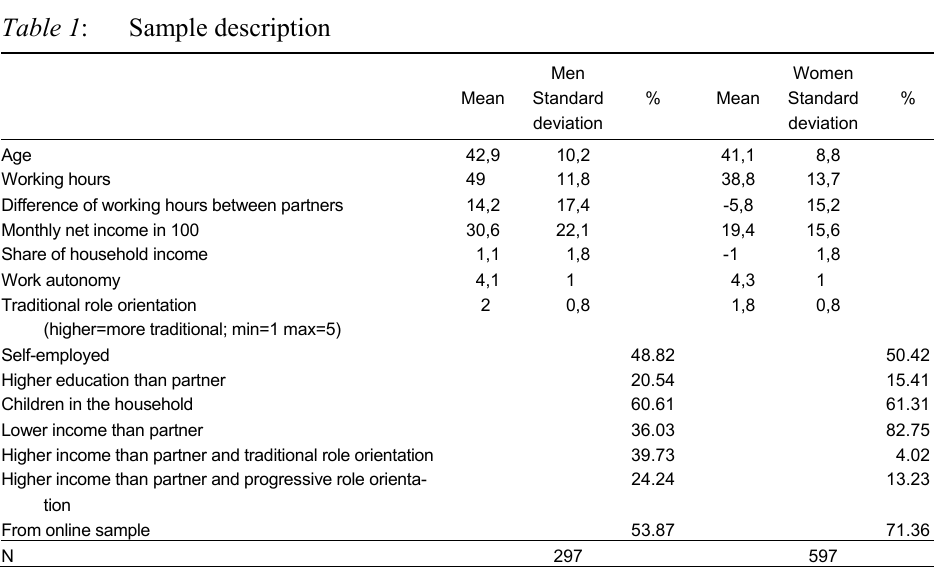
Sample description